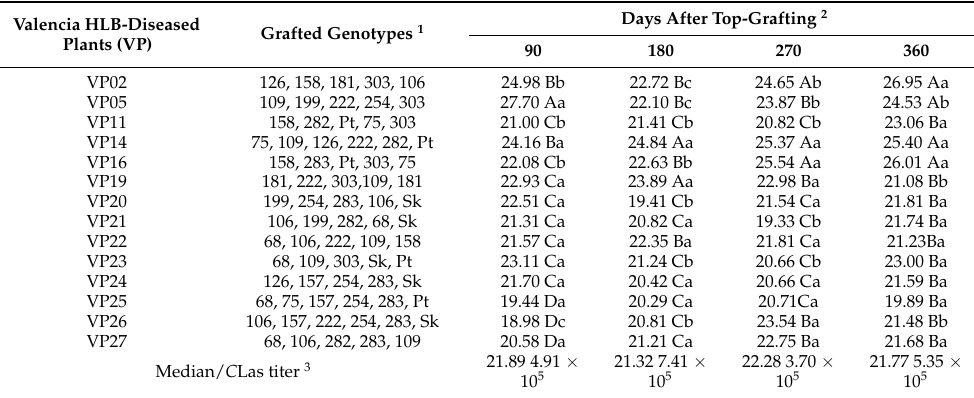
Table 1. C T values of different Valencia HLB-diseased plants infected by Candidatus Liberibacter asiaticus ( C Las) that received the citrandarin genotypes (hybrids and parents) by top-grafting. Plants were analyzed for 12